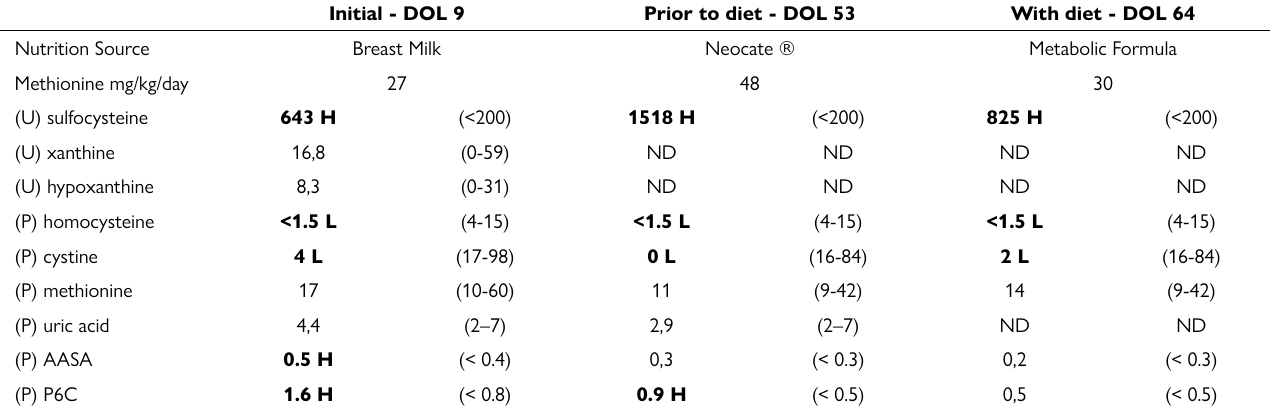
Table 1. Urine and plasma biochemical markers at the time of diagnosis and during follow